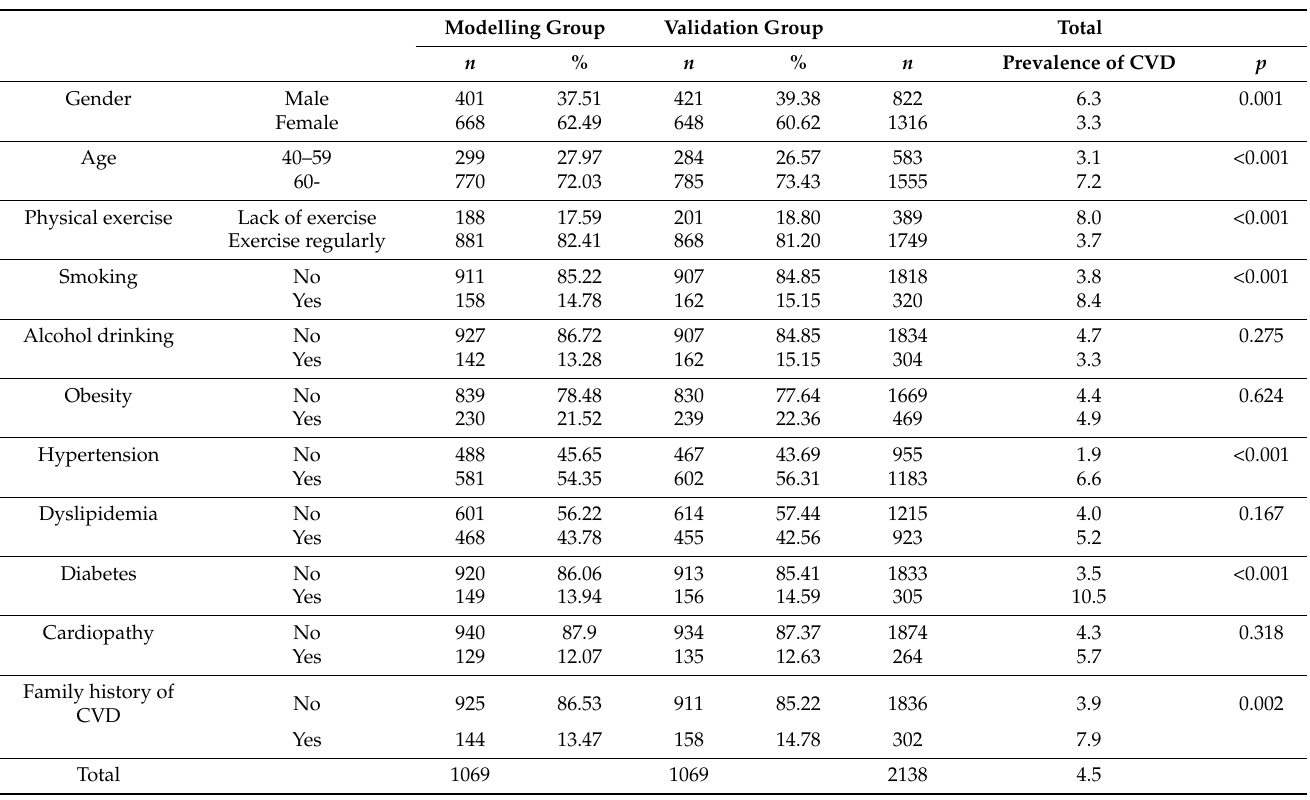
Table 3. The prevalence of cerebrovascular disease.